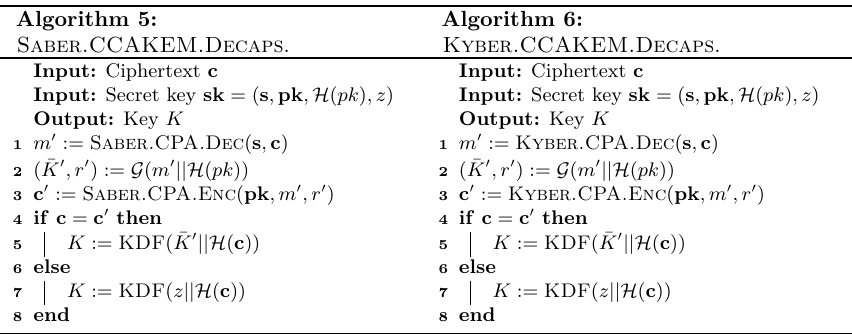
Algorithm 5: Saber.CCAKEM.Decaps .